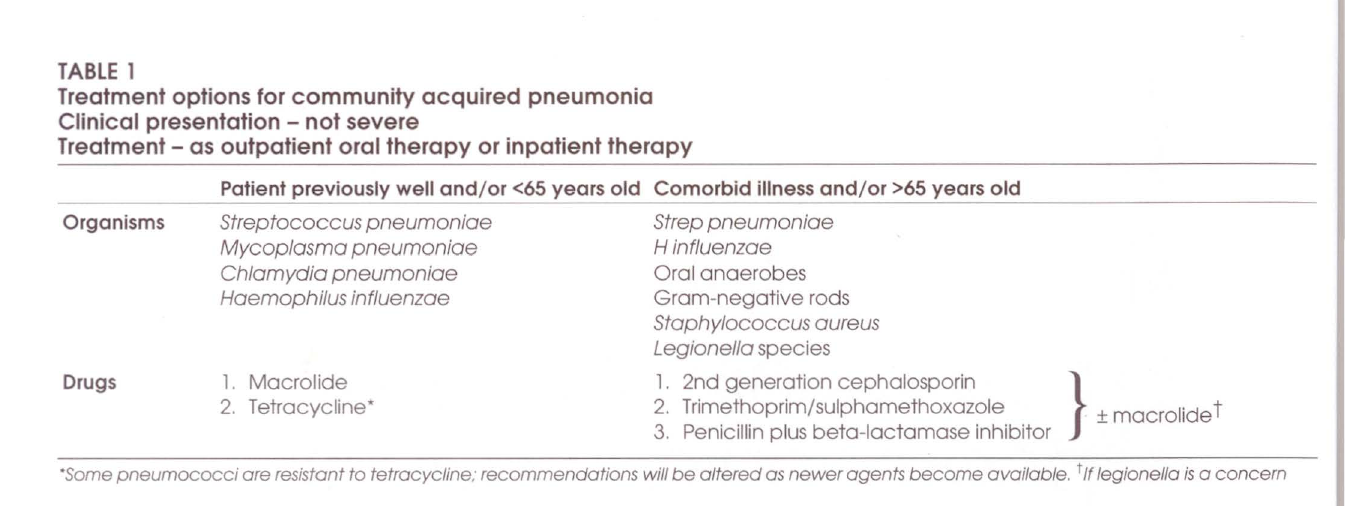
TABLE 2 Treatment options for community acquired pneumonia Clinical presentation - severe Treatment - in